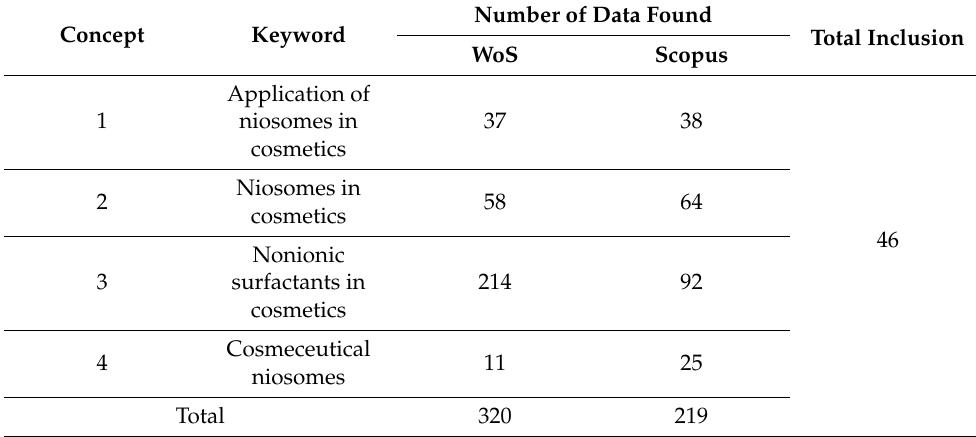
Table 3. Database search, keywords used, number of data found, and number